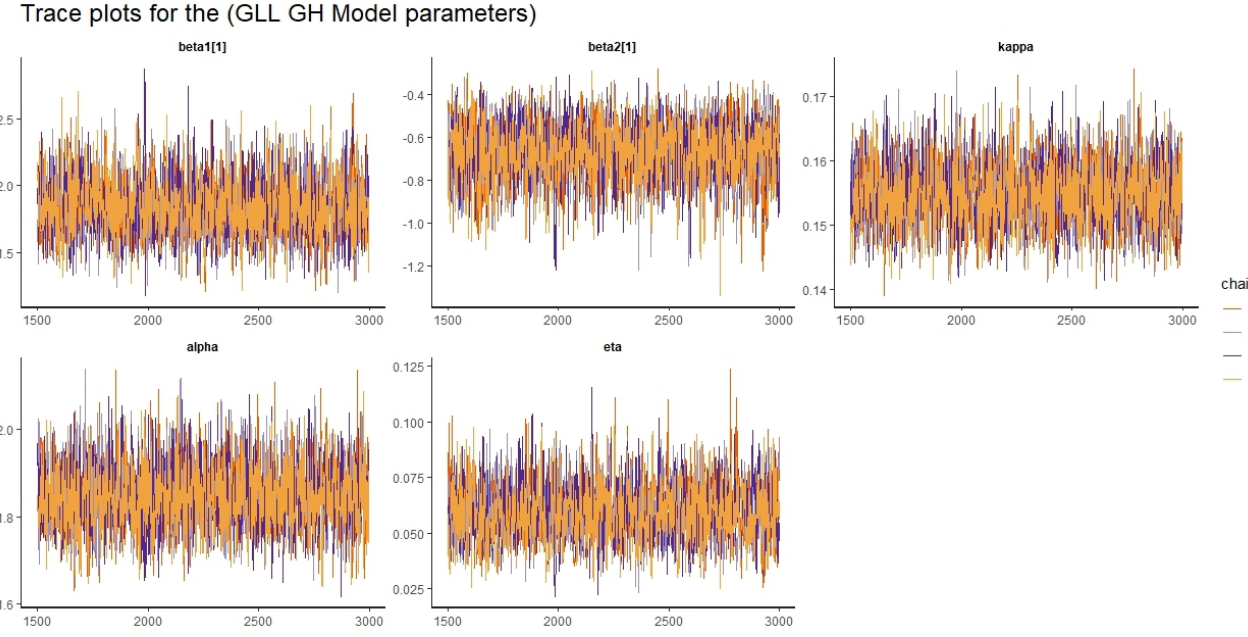
Figure 7. Trace plots for the GLL − GH model